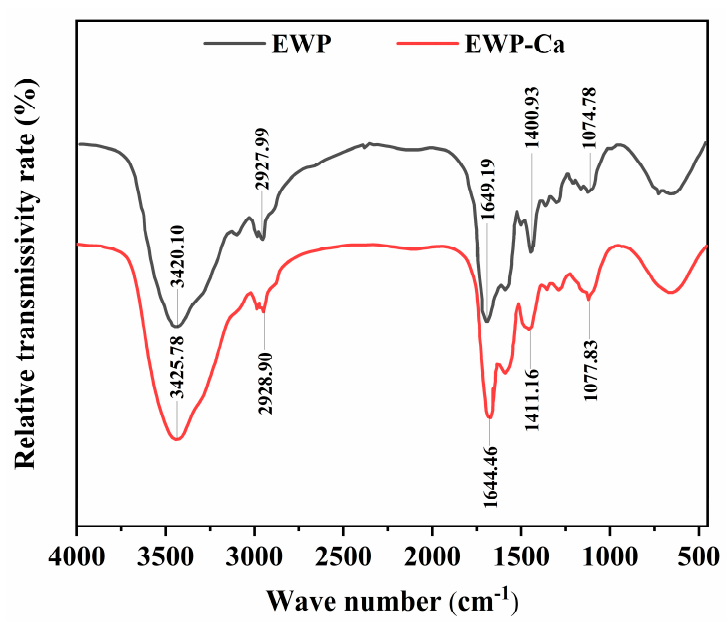
Figure 3. FTIR spectra of EWP and EWP-Ca from 4000 to 450 cm − 1 Figure 3 . FTIR spectra of EWP and EWP-Ca from 4000 to 450 cm − 1 .